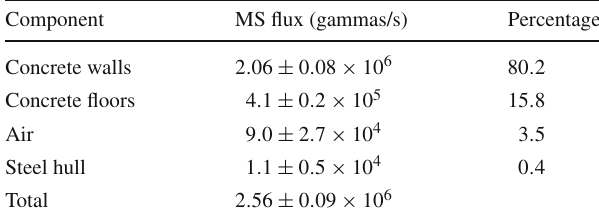
Fig. 2 The Geant4 simulation geometry, consisting of the steel MS (red), the concretewalls(gray) andfloors (green), and, optionally, water tanks (blue) and basin water (purple). The yellow sphere indicates the position of the optional 60 Co source. The coordinate axes for the exper- iment are also shown, where the z -direction ( x -direction) corresponds to due north (west). For orientation, the FPD is located north of the spectrometer Table 2 Simulated total gamma fluxes integrated at the inner surface of the MS. For each component, the flux was calculated based on the activities listed in Table 1, after summing the individual contributions from the different radioisotopes. The errors are purely systematic and indicate the uncertainty of the component